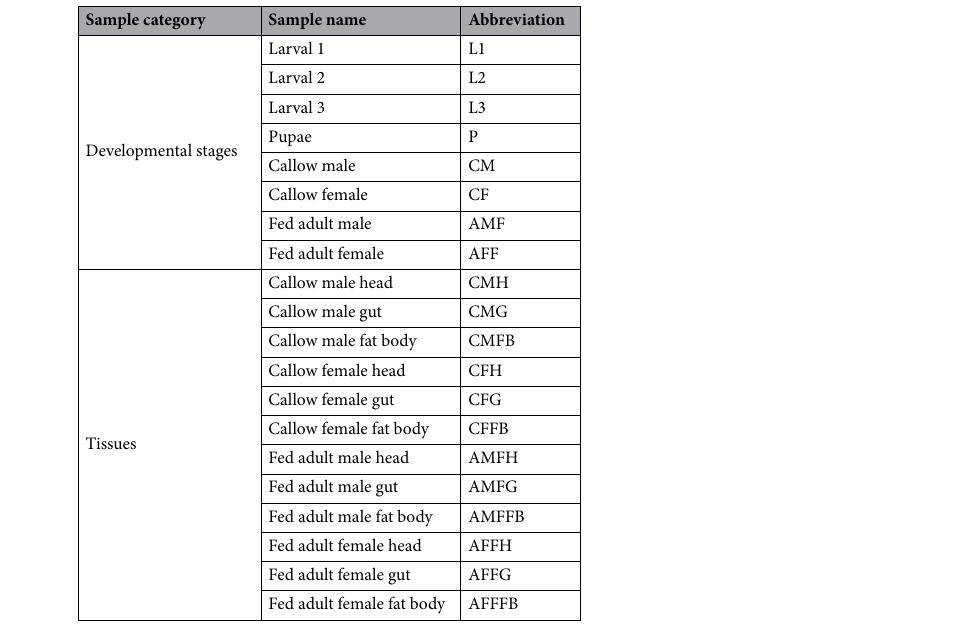
Table 1. Detailed sample list of I. typographus life stages and tissue types used for reference gene experiments.